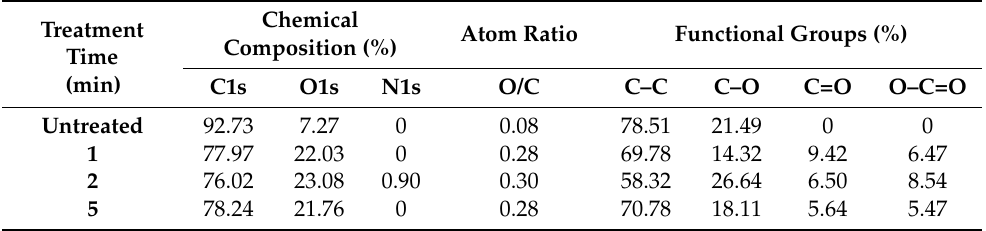
Figure 8. XPS spectra of ( a ) UHMWPE films with different plasma treatment time. C1s core level spectra of UHMWPE samples ( b ) without plasma treatment, and after plasma treatment for ( c ) 1 min, ( d ) 2 min and ( e ) 5 min. Table 2. Surface chemical composition and functional groups of UHMWPE films treated for different times based on the deconvolution of C1s peaks.